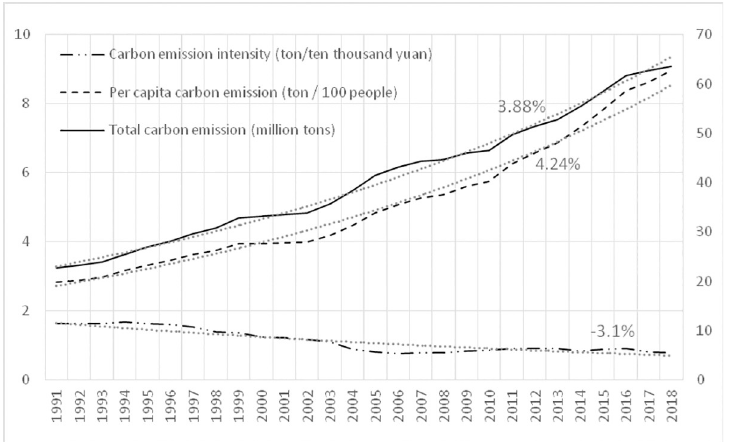
Fig 1. Agricultural carbon dioxide